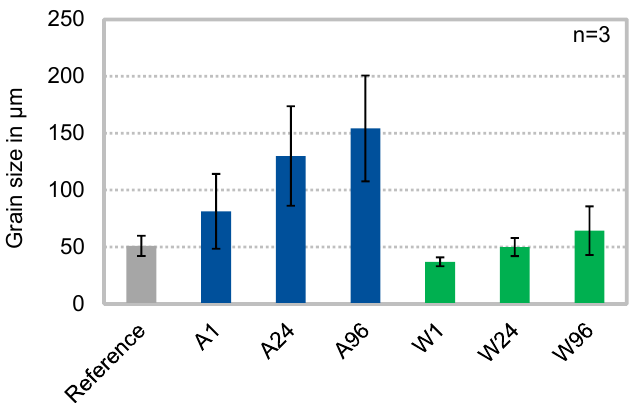
Figure 1. Grain size of the platelets as a function of the solution heat treatment duration and cooling conditions, taking into account the standard deviation and the sample size